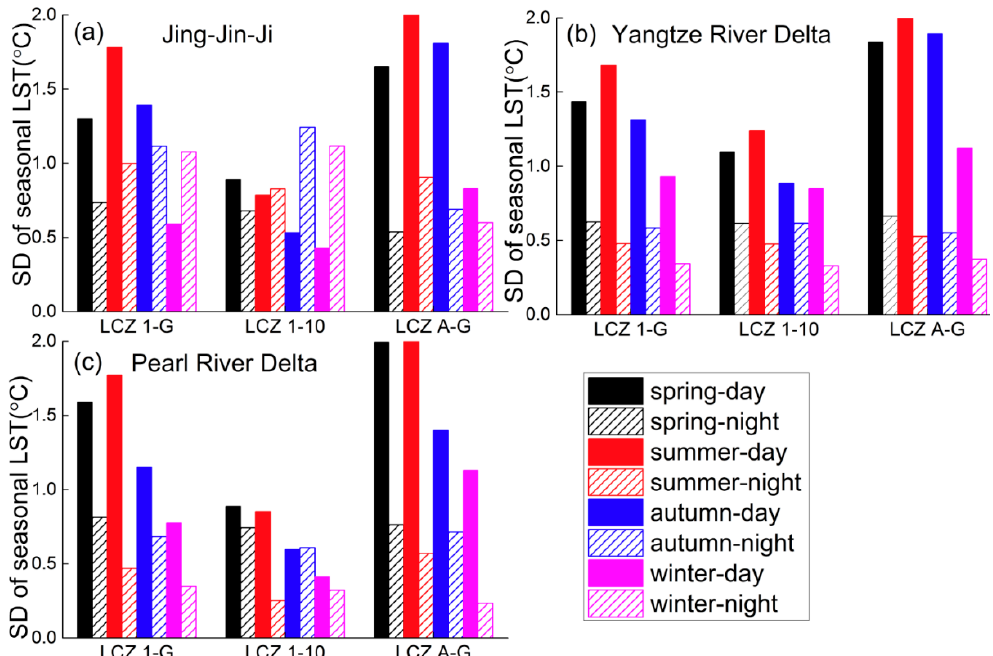
Figure 5. Standard deviation (SD) of seasonal daytime and night time mean LST for LCZs 1–17, LCZs 1–10 and LCZs A-G, respectively, in Jing-Jin-Ji ( a ), Yangtze River Delta ( b ) and Pearl River Delta ( c ).